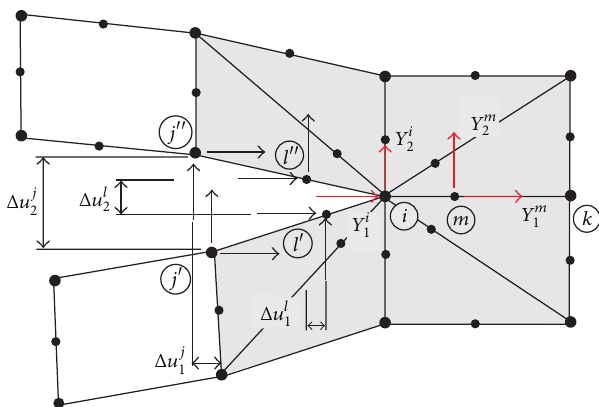
Figure 4: A crack tip rosette of singular quarter-point finite